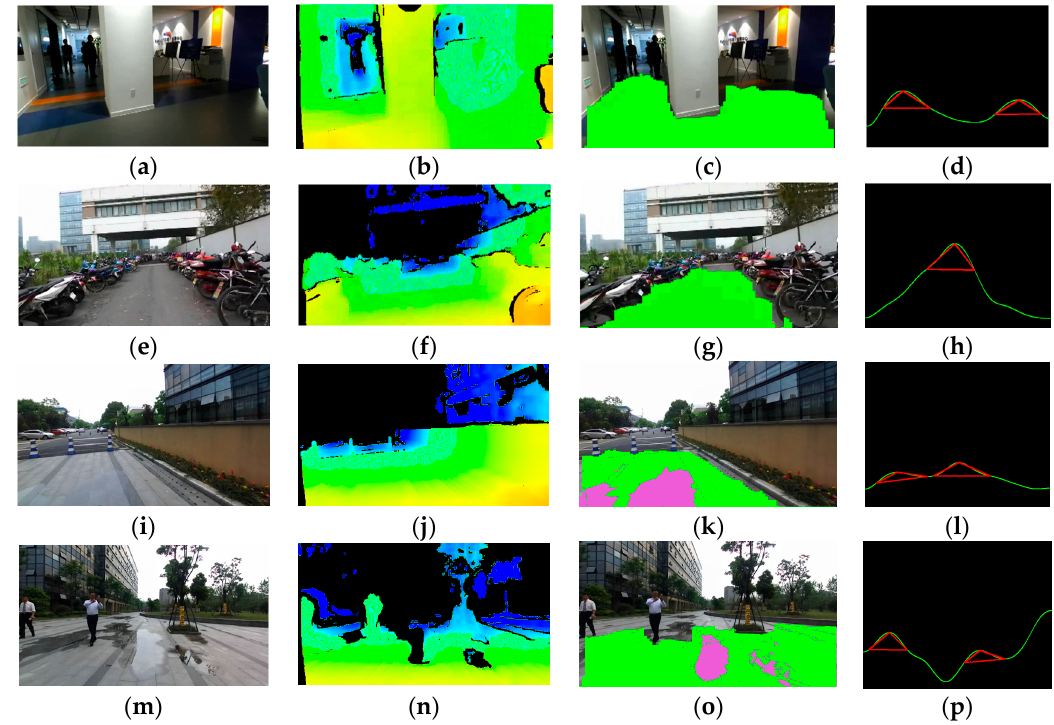
Figure 11. Results of traversable area and water hazard detection in indoor and outdoor environments. ( a , e , i , m ) Left color images; ( b , f , j , n ) Depth images; ( c , g , k , o ) Traversable area and water hazard detection results denoted respectively by the green and magenta masks on the left color images; ( d , h , l , p ) Farthest traversable lines as stereo sound feedback interface.